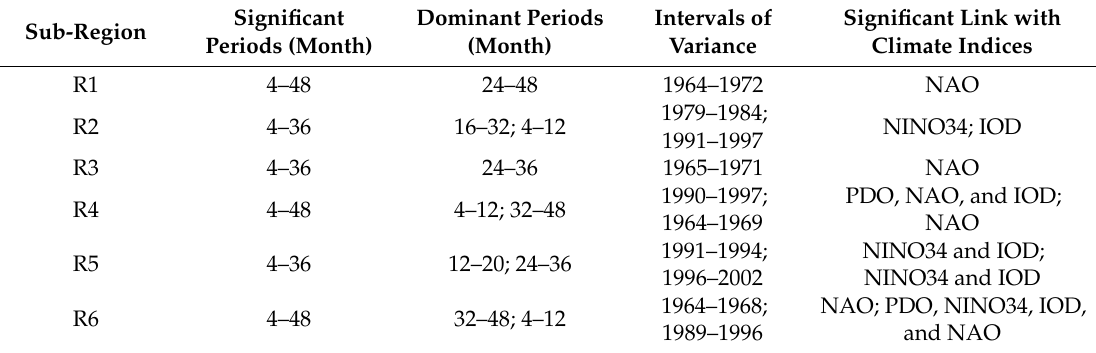
Table 5. Periodicity of drought variability and its link with climate indices from 1961 to 2004 in the six